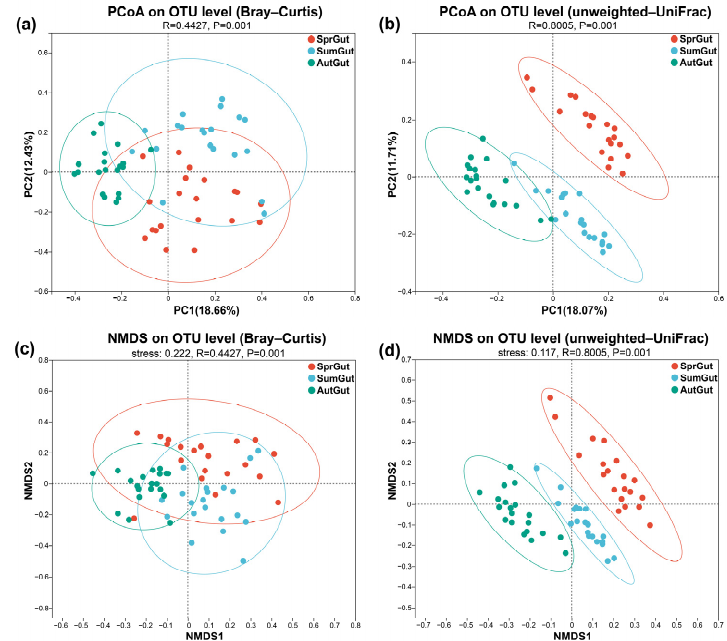
Figure 4. PCoA analysis based on ( a ) Bray–Curtis and ( b ) unweighted–UniFrac distances, and NMDS analysis based on ( c ) Bray–Curtis and ( d ) unweighted–UniFrac distances of the gut microbiome from the studied seasons.